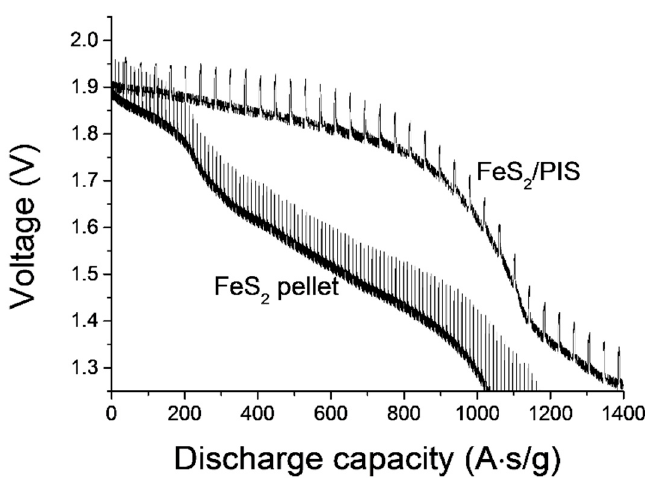
Figure 6. Discharge capacities of the FeS 2 /PIS thin layer cathode and the pellet-type FeS 2 .